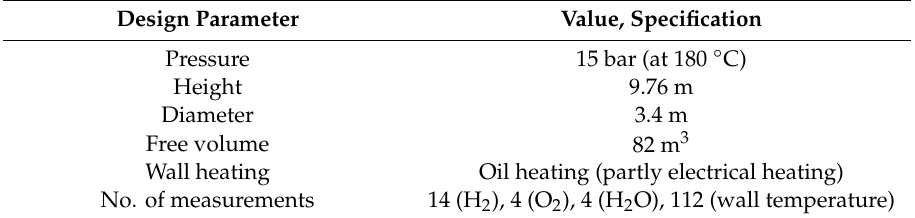
Figure 1. Configuration of the SPARC test facility: ( a ) Overall view of test apparatus; ( b ) Geometric dimension of the SARC test vessel. Table 1. Design specifications of the test